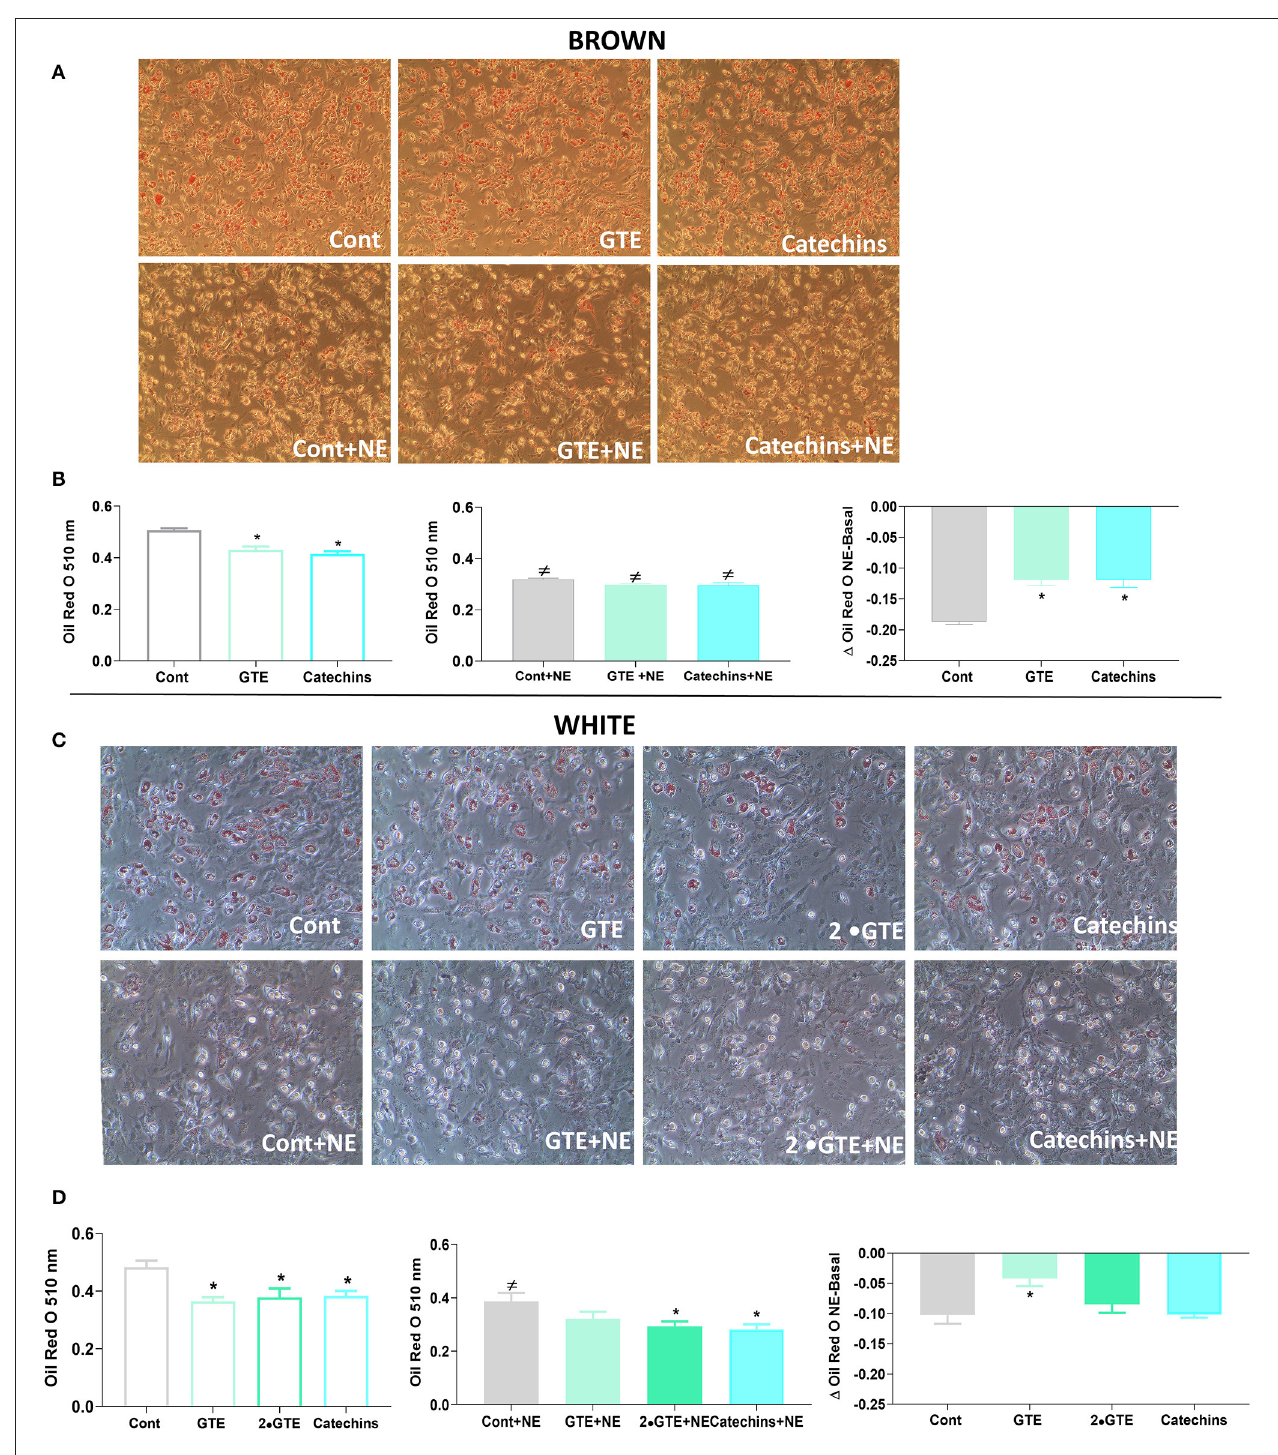
FIGURE 2 | Effect of green tea compounds on lipid accumulation. Representative morphology of primary brown (A) and white adipocytes (C) is described in Figure 1 . After norepinephrine stimulation, the adipocytes were stained with Oil Red O as described in section Materials and methods. Quantification of Oil Red O staining of brown (B) and white adipocytes (D) in basal and NE-stimulated states and the norepinephrine-induced change. The results are means ± SEM of four independent experiments, each performed in duplicate wells per group. Statistics are as in Figure 1 .